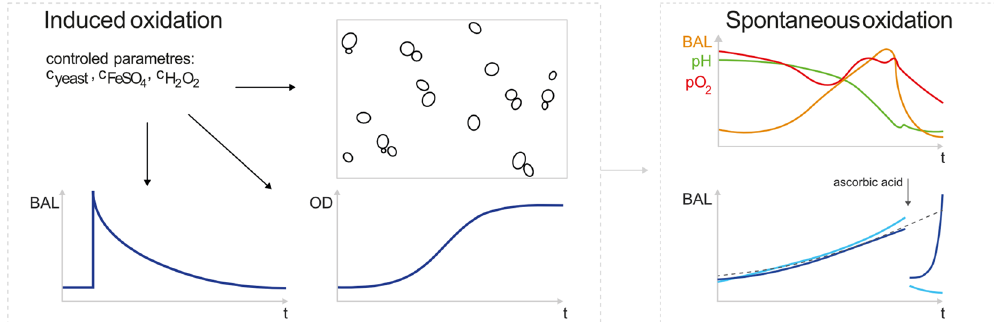
Figure 2. A schematic summary of the parameters and processes related to biological autoluminescence (BAL) explored in this paper. We analyzed the BAL and related parameters both under the conditions of induced and spontaneous (endogenous) oxidation in the yeast cell cultures. For induced oxidation, the amount of free radicals in a sample was regulated (increased) by the Fenton reaction. Then, the effects of various concentration of yeast and Fenton reagents ( FeSO 4 and H 2 O 2 ) on BAL, growth curves, and cell clustering was analyzed. The BAL due to spontaneous oxidation processes and its correlation with several selected parameters (pH, pO 2 , concentration of antioxidant ascorbic acid) were